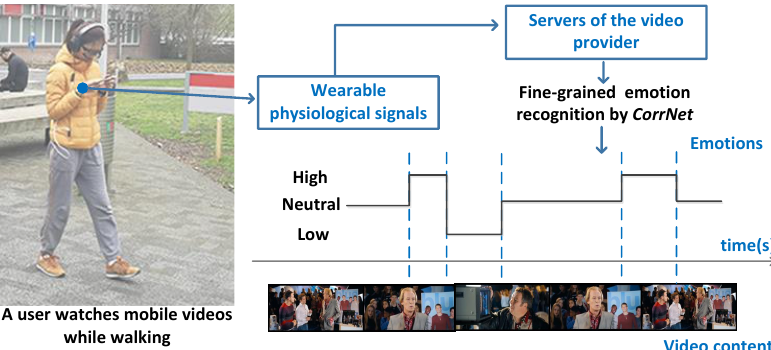
Figure 3. The experiment environment of MERCA. Participant photos shown with permission.